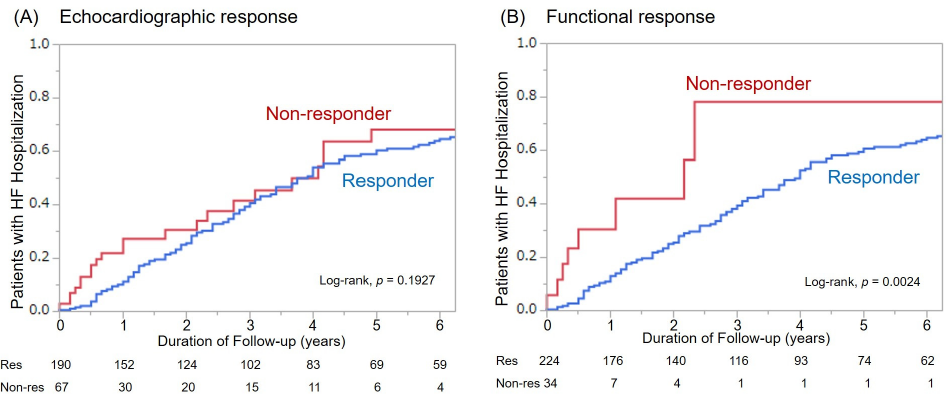
Figure 2. Hospitalization for heart failure among responders and non-responders based on both response definitions . A: Echocardiographic response, B: Functional response